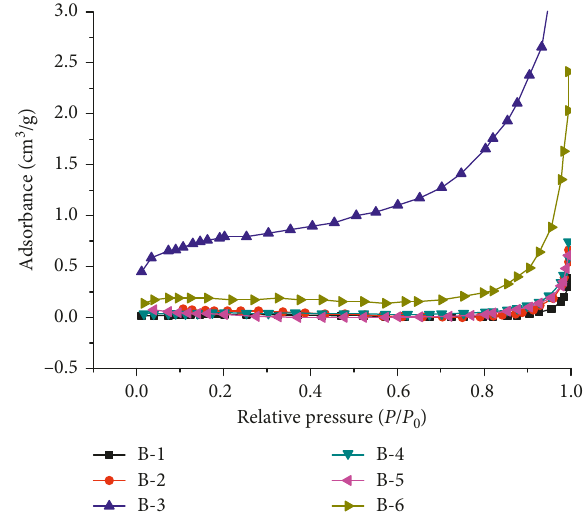
Figure 6: Adsorption isotherms of nitrogen for the raw coal